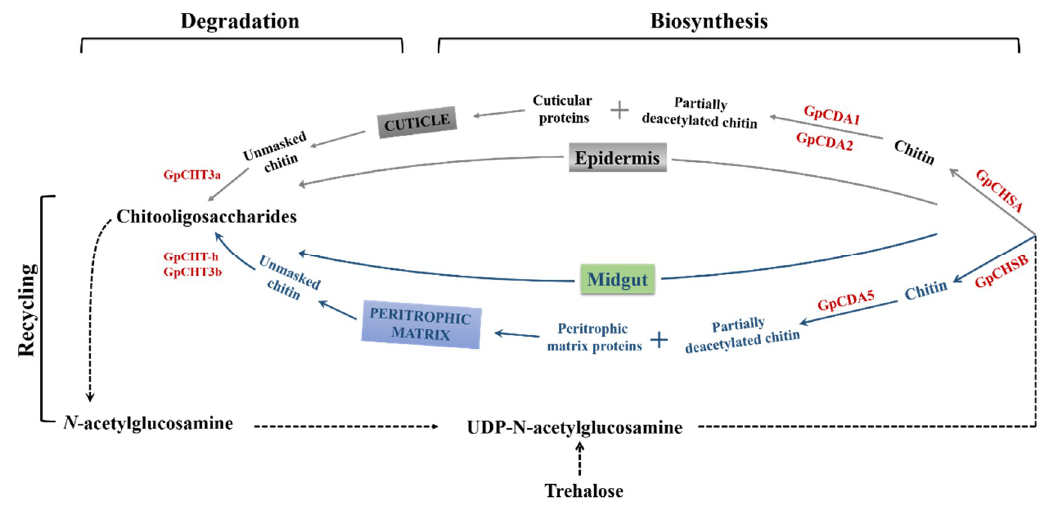
Figure 10. The hypothesis of the role of GpCHSA and GpCHSB and their downstream genes in chitin metabolism in G. pyloalis . GpCHSA and GpCHSB are involved in cuticle and PM chitin metabolism, respectively . GpCHSA regulates the expression of GpCDA1 , GpCDA2 and GpCHT3a . GpCHSB regulates expression of GpCDA5 , GpCHT-h and GpCHT3b . Genes analyzed in this study were highlighted with the red color.